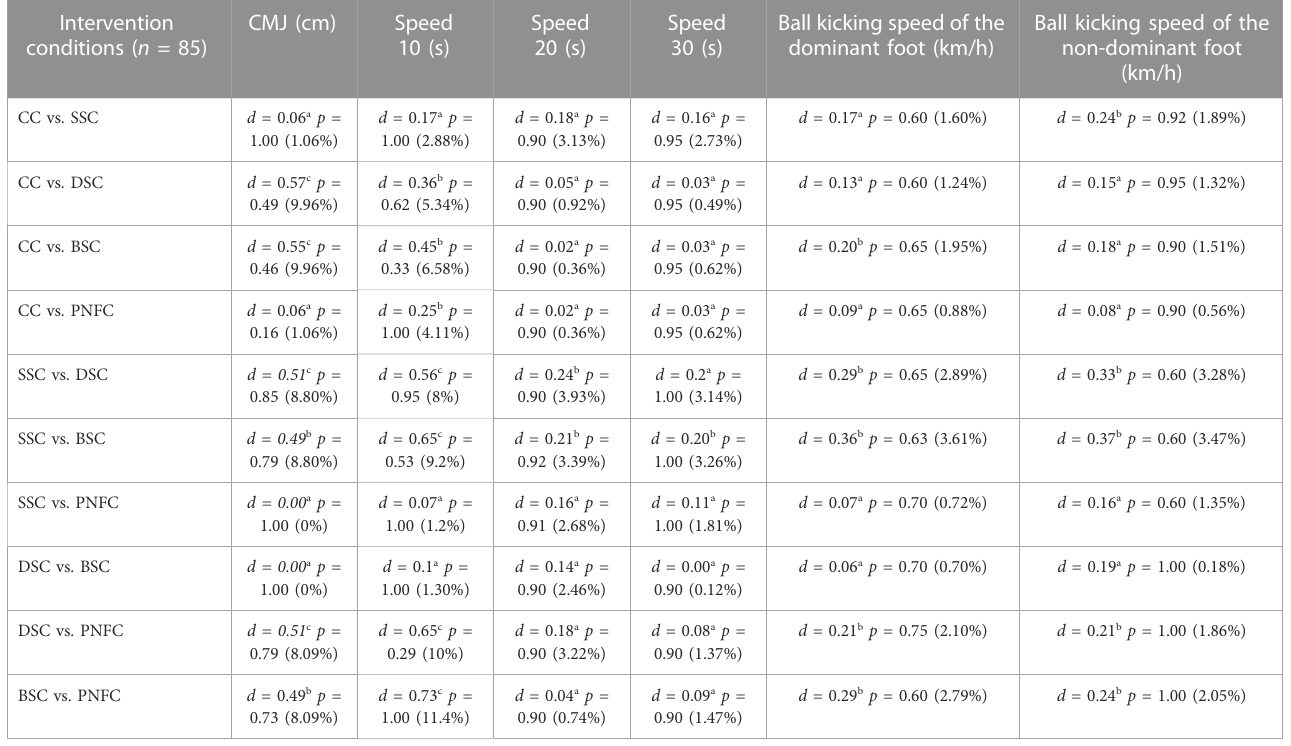
TABLE 2 Differences between intervention conditions of youth ’ s male soccer players. Intervention conditions ( n =